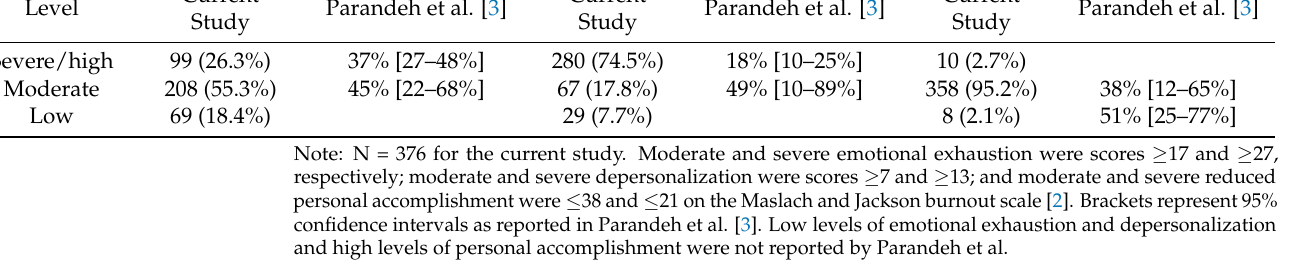
Table 2. Means, standard deviations, inter-correlations, and internal consistency reliability estimates for study variables.